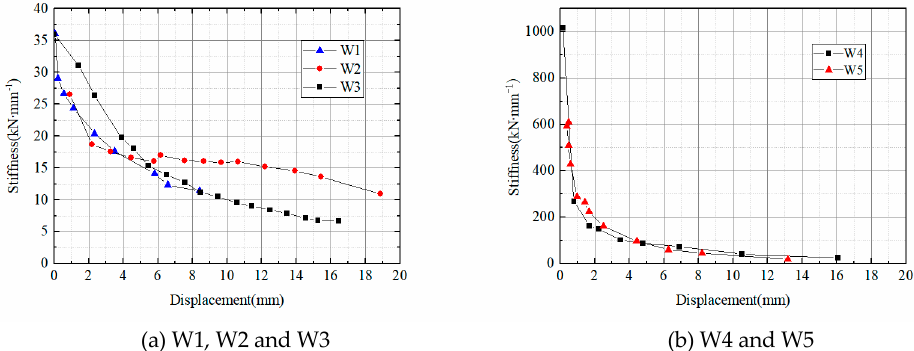
Figure 11. Stiffness deterioration curves of specimens: ( a ) W1, W2, and W3; ( b ) W4 and W5. Figure 11. Sti ff ness deterioration curves of specimens: ( a ) W1, W2, and W3; ( b ) W4 and